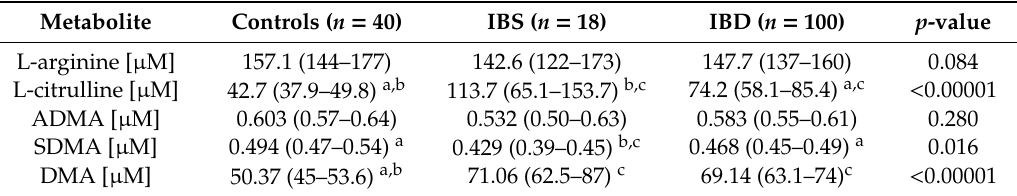
Table 1. L-arginine / NO pathway metabolites in IBD and